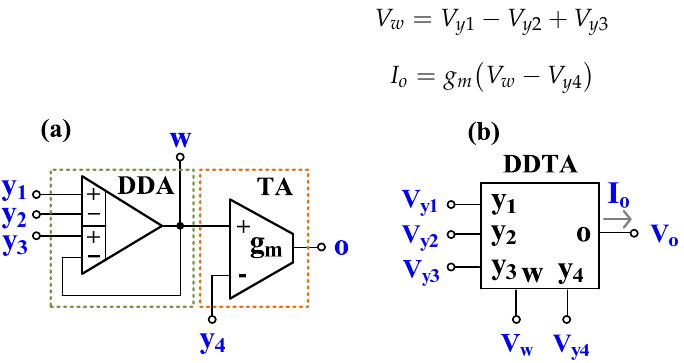
Figure 1. DDTA, ( a ) possible realization of DDTA, ( b ) electrical symbol.